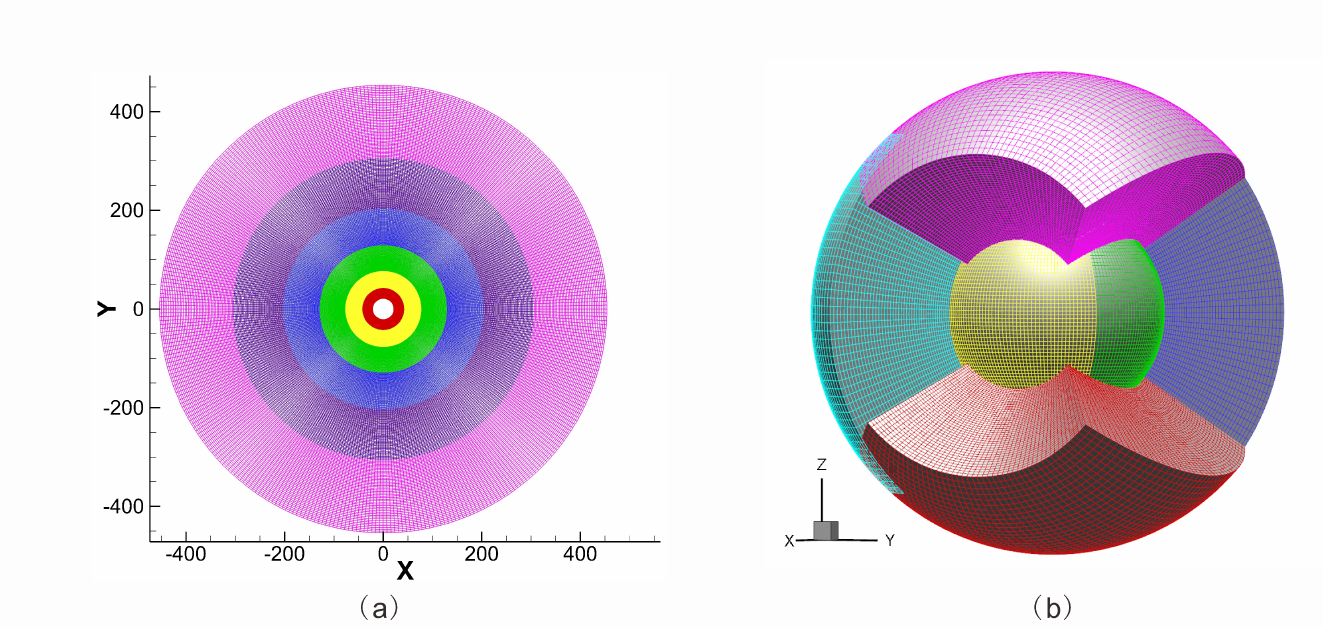
Figure 1. The grid system of our 3-d MHD interplanetary solar wind model. The left panel ( a ) shows the grid division on the radial direction, and the right panel ( b ) shows the spherical six-component grid system in a 3-d